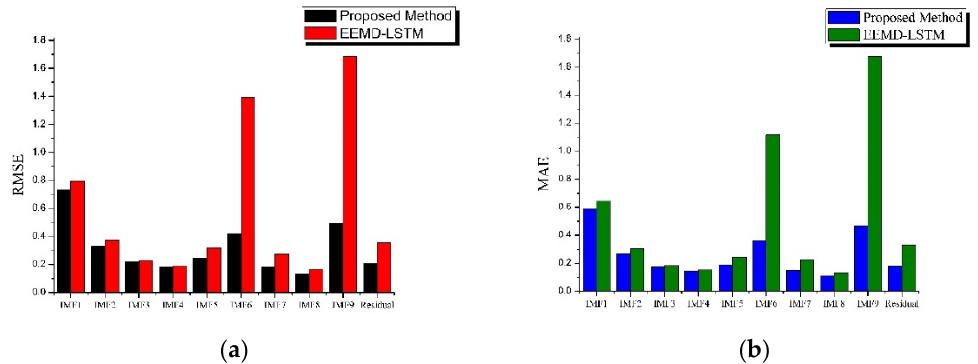
Figure 10. Error estimate results for propagation-loss subsequences in an oceanic surface duct: ( a ) root mean square error (RMSE); ( b ) mean absolute error (MAE). Table 9. Percentage improvement in propagation-loss subsequences prediction capability by GA (evaporation duct).